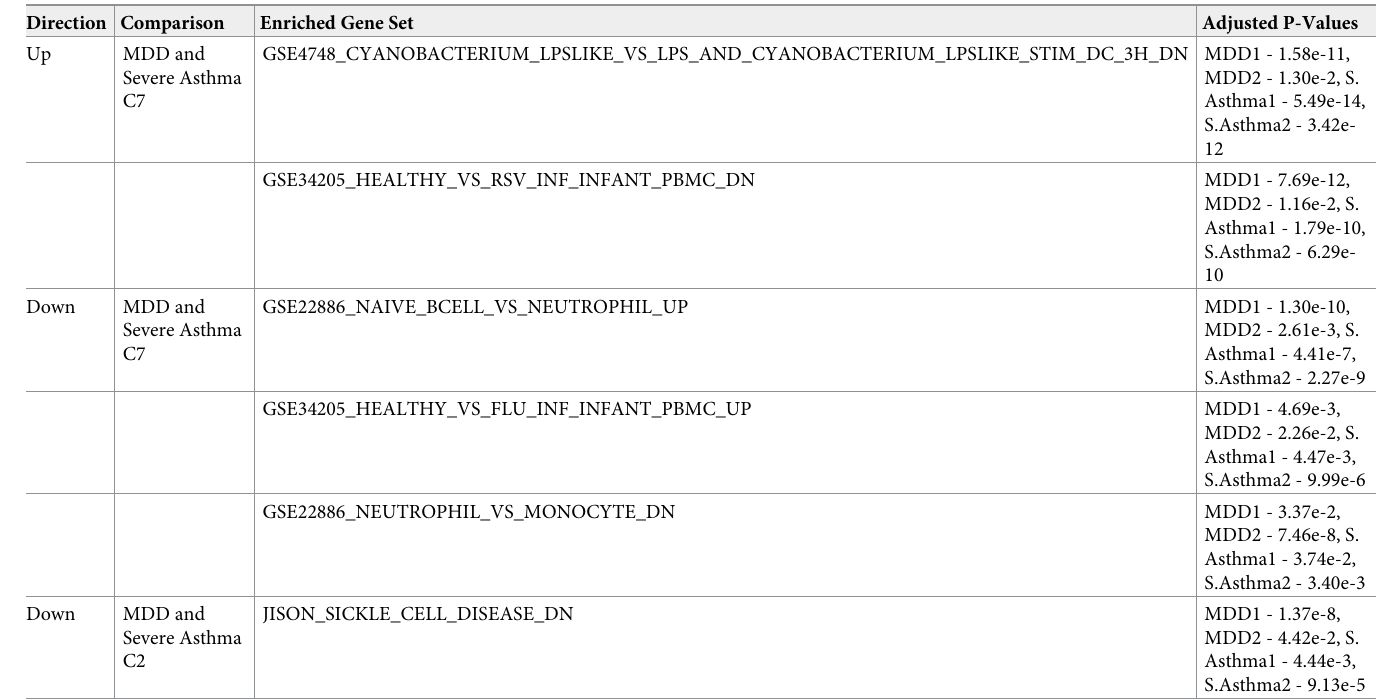
Table 1. Directionally validated pathway comparisons in the Hallmark, C2, and C7 collections. Direction